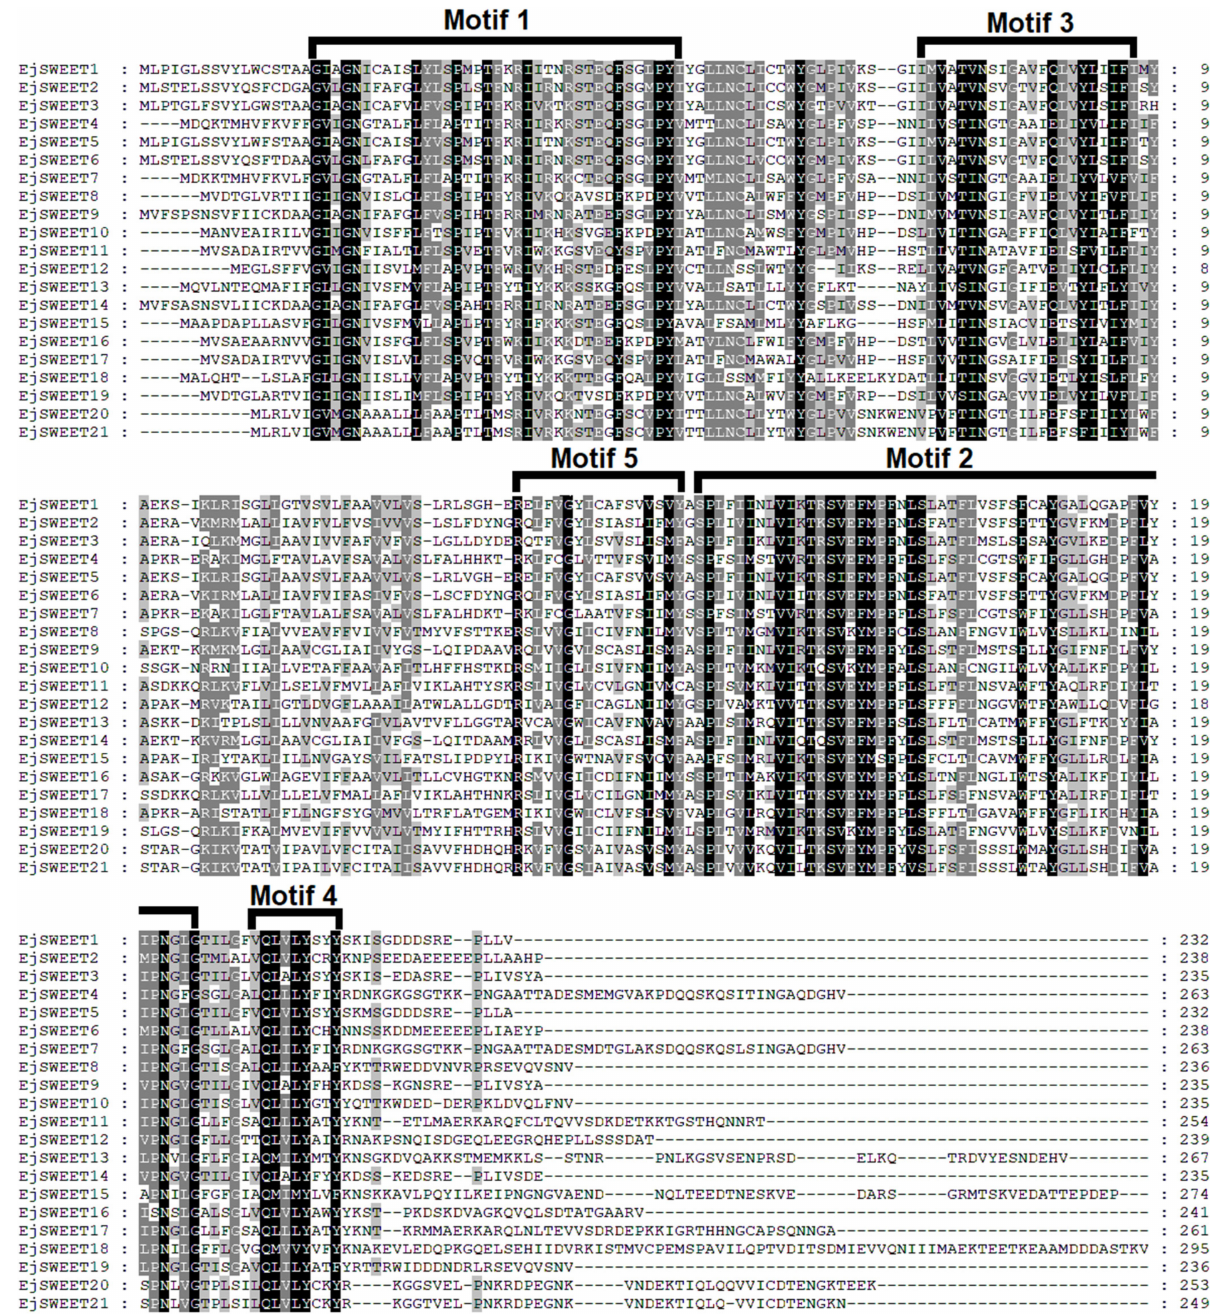
Figure 5. Multiple sequence alignment of the EjSWEETs . The positions of the seven motifs are indi- cated above the sequences. Highly conserved amino acids (>80%) are shaded with black, moderate conservation (60–80%) is with grey, while the non-shaded amino acids represent less conserva- tion